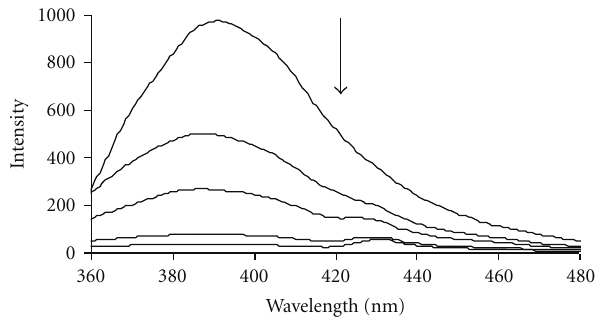
Figure 6: E ff ect of DNA on the fluorescence spectra of Pt complex (8 . 34 × 10 − 5 M) in Tris-HCl (10mM) bu ff er. r i = [DNA]/[Complex] = 0.0, 0.2, 0.6, 0.8, 1, 1.2. Figure 7: E ff ect of Pt complex on fluorescence spectra of NR-DNA.